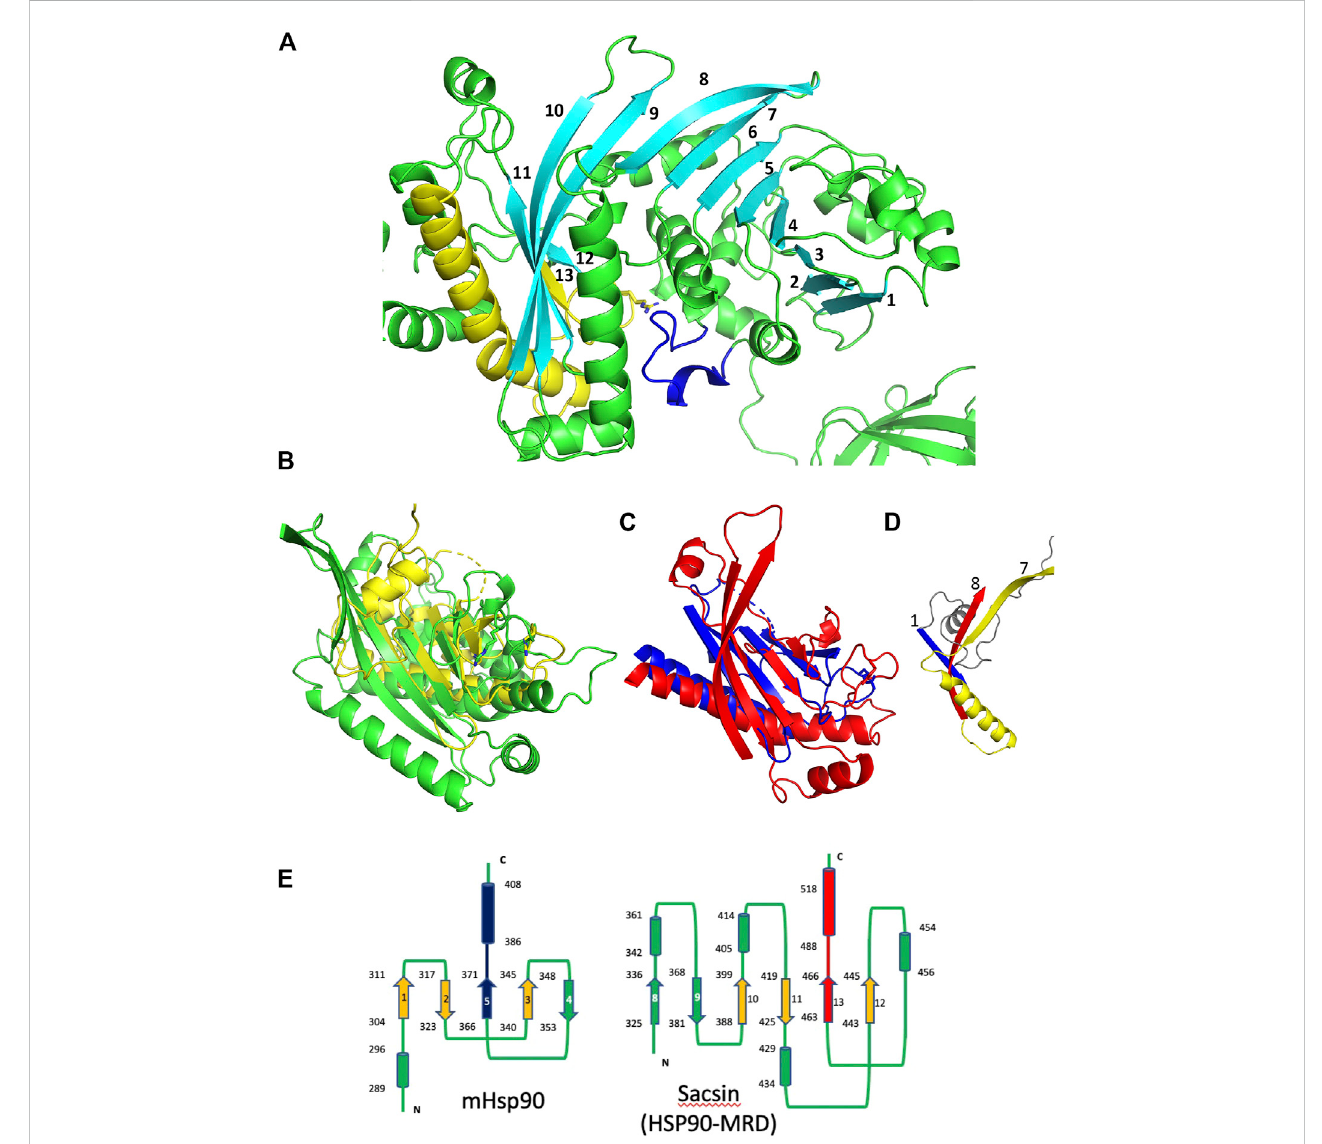
FIGURE 6 ComparisonoftheHsp90middledomainwithcorrespondingsacsinregions. (A) PyMolcartoonoftheSR1domainandimmediatedownstreamregionof sacin (green and cyan). A continuous 13 stranded β -sheet runs from the SR1 domain and into the adjacent domain of sacsin. Cyan, β -strands, yellow, the β - strand and helix fl anking the catalytic loop (yellow). Blue, the lid segment of the SR1 domain of sacsin. (B) PyMol cartoon showing the superimposition of the Hsp90 middle domain (yellow, residues 262-444) and the corresponding sacsin region (green, residues 325-518). (C) The central core structural elements of the middle domain of Hsp90 (blue) and the corresponding region of sacsin (red) show the main elements that superimpose. (D) PyMol cartoon showingtheN-terminal structural elements oftheHsp90middle domain (blue andgrey)and thecorresponding elements ofsacsin(redand yellow), showing that these structural elements do not superimpose. Strand 7 and 8, sacsin SR1 β -strands and strand 1, Hsp90 middle domain β -strand. (E) Topology diagrams for the middle domain of Hsp90 (left panel) and the corresponding region of sacsin (right panel, HSP-Middle Repeat Domain (HSP-MRD)). Cylinders, α -helix, arrows, β -strand and lines are connections between the structural elements. The start and end residue numbers of each structural element are shown, as are the β -strand numbers. Blue and red, structural elements that represent the arginine catalytic loop and the fl anking structural elements. Alignment of the red and blue β -strand and α -helix allows the superimposition of the orange β